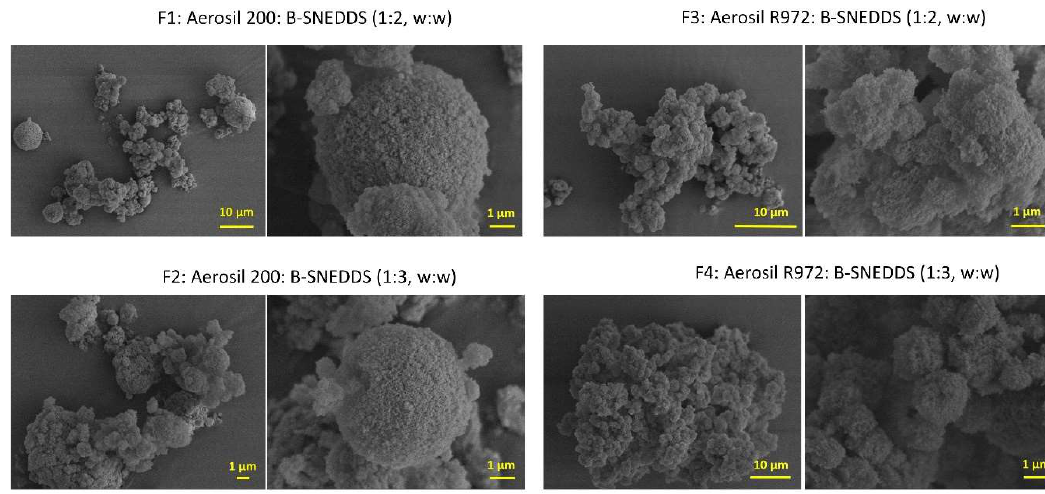
Figure 3. Scanning electron microscope (SEM) micrographs of solid B-SNEDDS F1, F2, F3, and F4 formulations at two different magnifications.